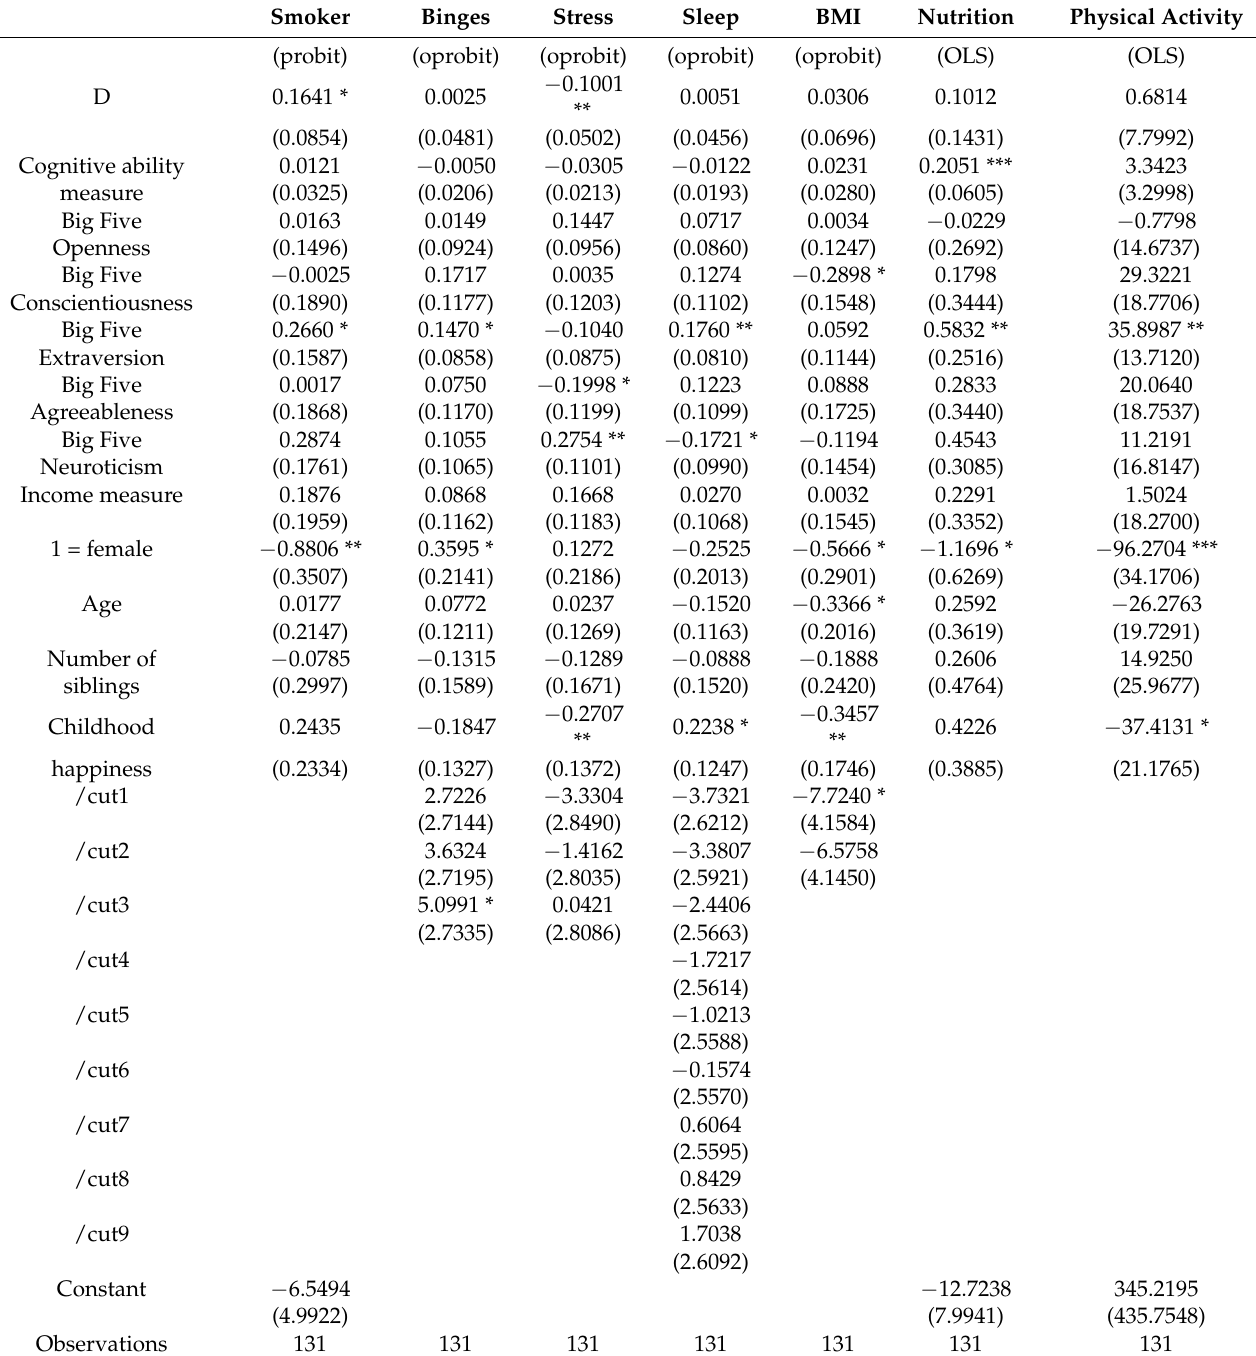
Table A2. All estimated